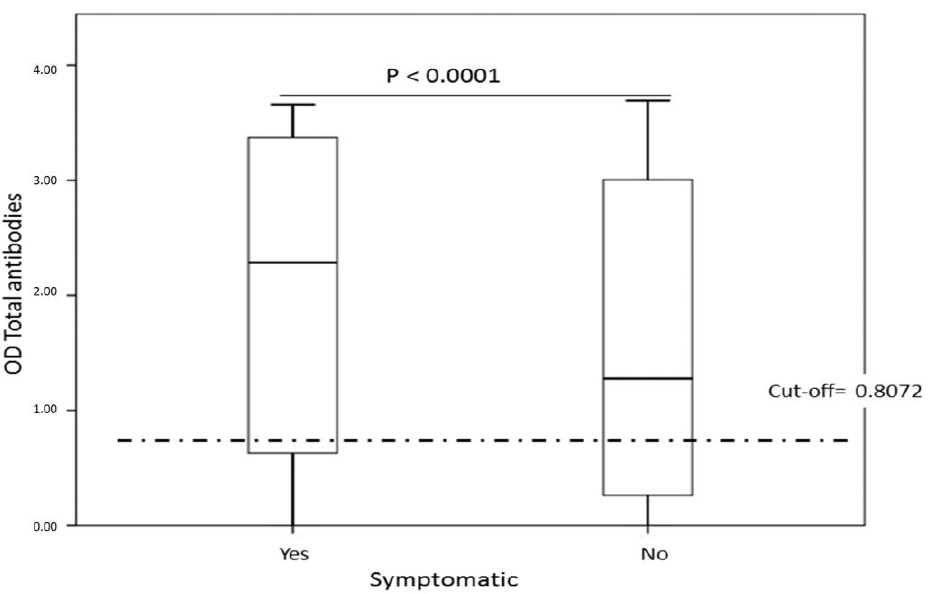
Figure 5. Relationship between the presence of clinical manifestations and a positive serological test for SARS-CoV-2. Higher seropositivity and OD of total antibodies are observed in individuals with clinical manifestations related to SARS-CoV-2 infection.